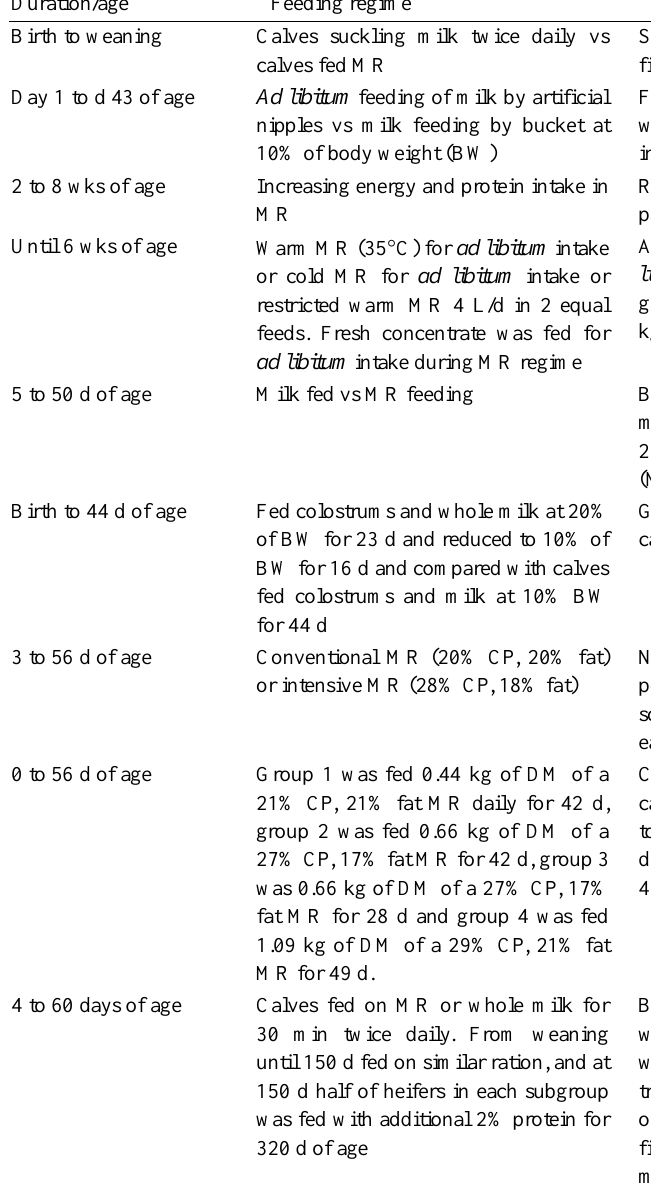
Table 1. Effect of feeding from birth to weaning on calf performance and milk yield potential Duration/age Feeding